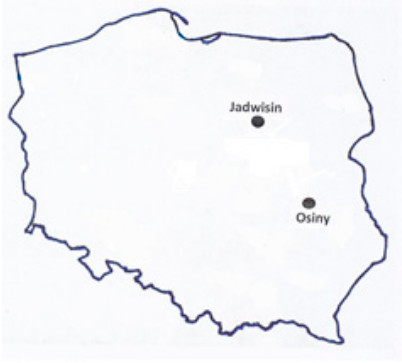
Figure 1. Places of investigation (Jadwisin, Osiny) in Poland .